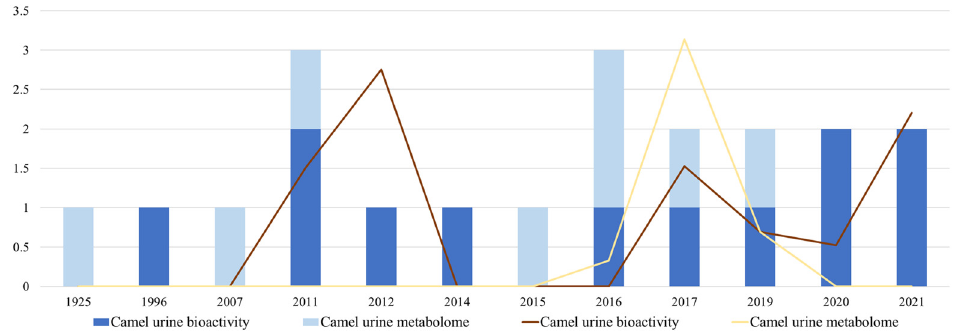
Figure 2. Number and impact factor of camel urine- and metabolome-related publications from 1925 to 2021. Bars represent the number of documents published per topic and year, while straight lines depict each year’s respective mean JCR impact index.